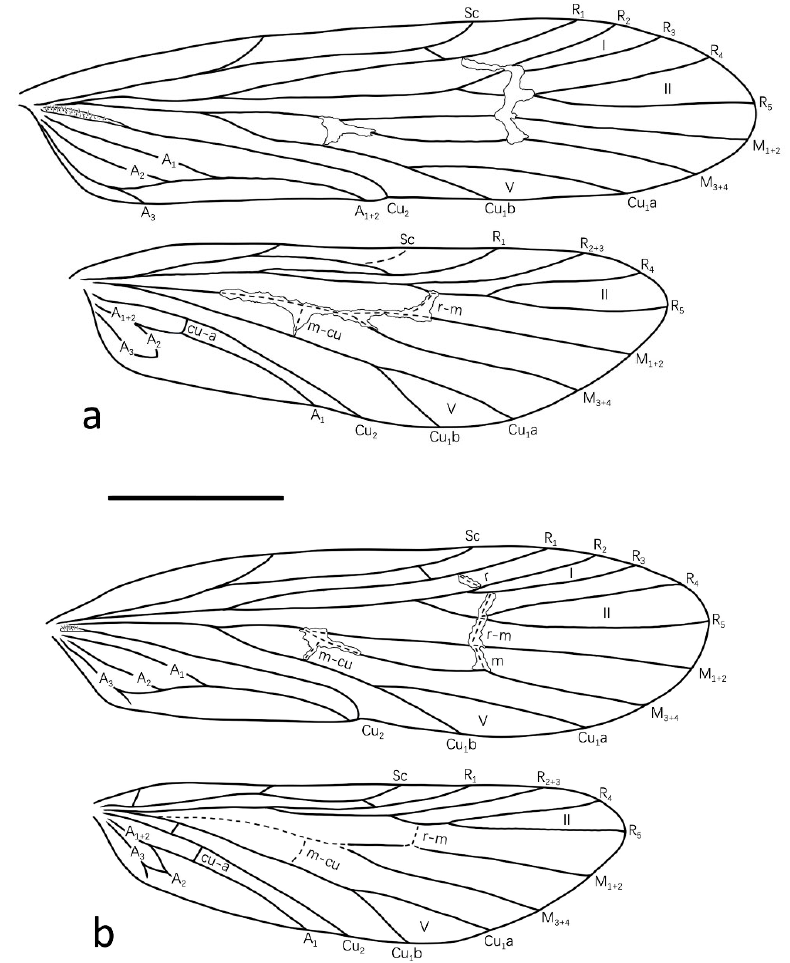
Figure 1. Wing venations of two new species of genus Gunungiella : ( a ) Gunungiella wangi , Peng, Ge and Sun n. sp.; ( b ) Gunungiella flabellate , Peng, Ge and Sun n. sp. Abbreviations: Sc = Subcosta; R = Radius; M = Media; Cu = Cunitus; A = Anal. Scale bar: 1 mm.